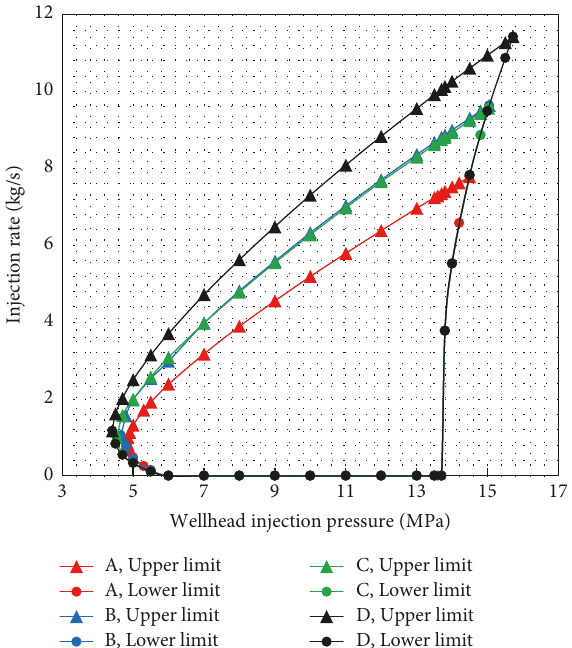
Figure 10: Relationship diagram between wellhead injection pres- sure and injection rate at different reservoir permeability.